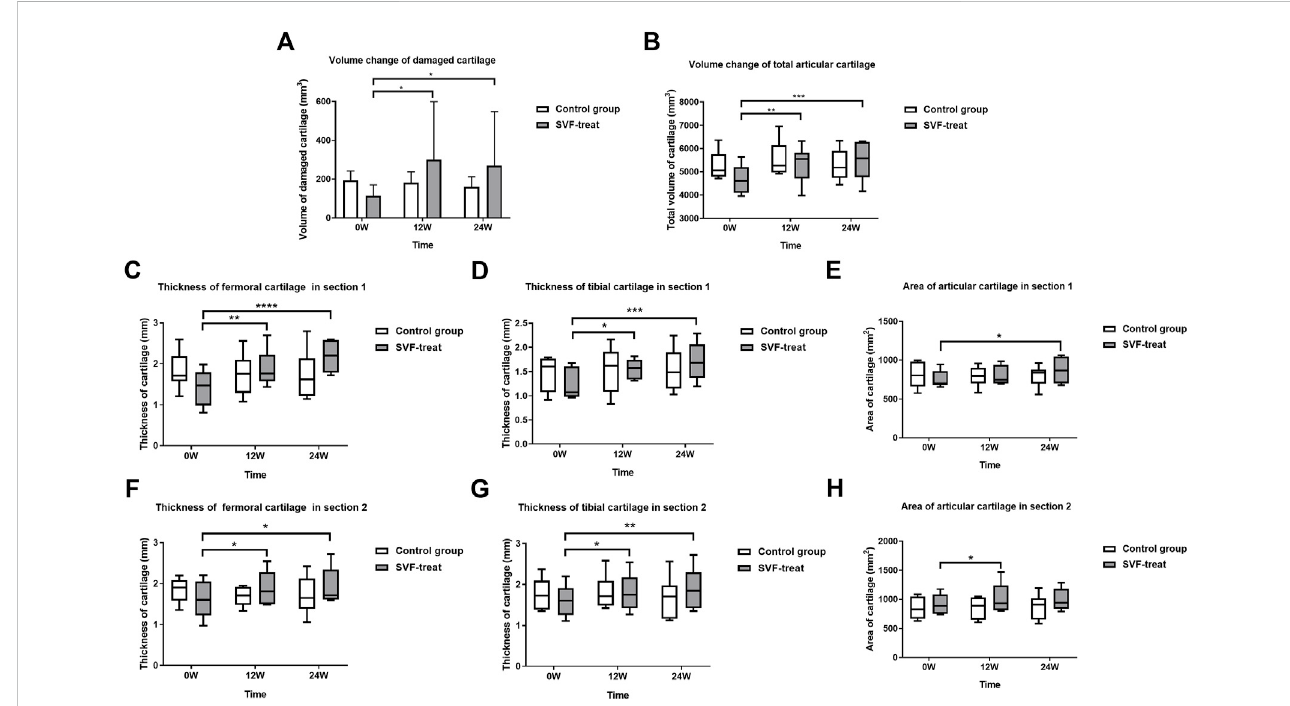
FIGURE 5 Radiologic evaluation of articular cartilage: volume, area and thickness. (A) Volume change of damaged cartilage. (B) Volume change of total articular cartilage. (C) Thickness of femoral cartilage in section 1. (D) Thickness of tibial cartilage in section 1. (E) Area of articular cartilage in section 1. (F) Thickness of femoralcartilageinsection2. (G) Thicknessoftibialcartilageinsection2. (H) Areaofarticularcartilageinsection2.Thevolumeofdamagedcartilageandtotal cartilage, thickness and area of articular cartilage improved signi fi cantly in SVF treated group at 12 and 24 weeks as compared to baseline, while no signi fi cant difference was observed in control